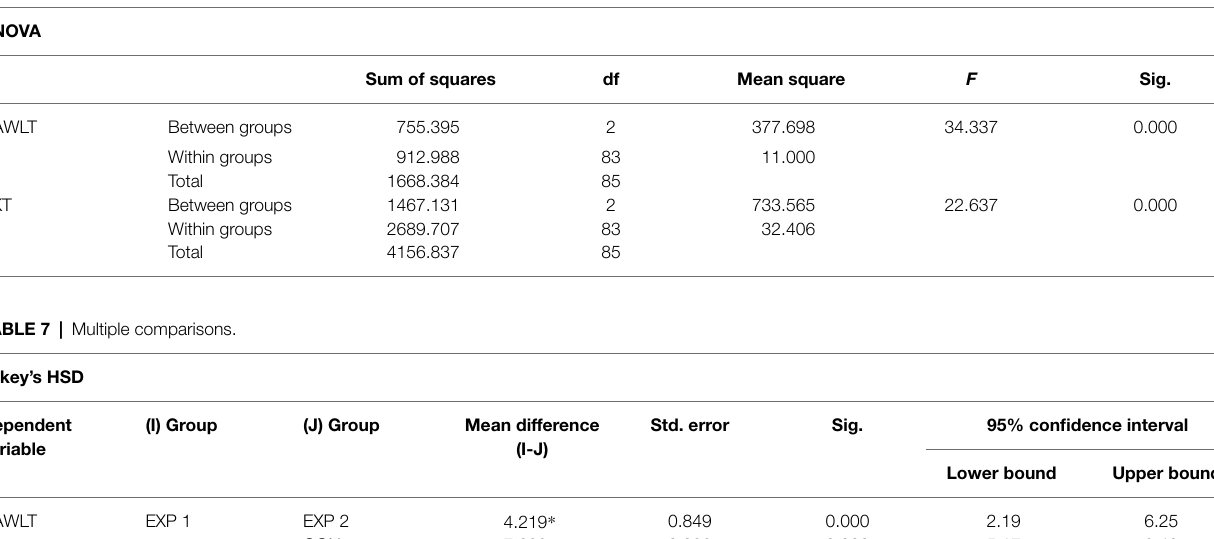
Sum of squares df Mean square